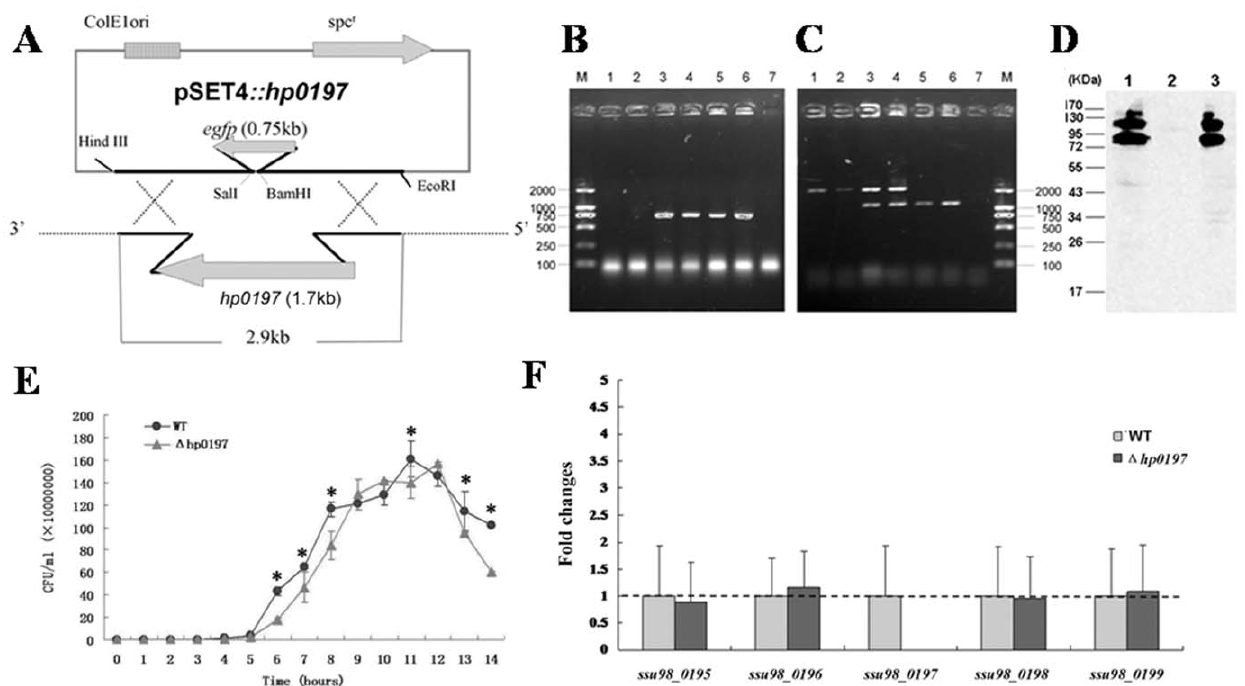
Figure 1. Construction and confirmation of D hp0197 and a complementary strain, c D hp0197 . ( A ) Construction strategy for D hp0197 , which was derived from the SS2 strain 05ZY. Approximately 600 bp of sequence flanking hp0197 was constructed into the temperature-sensitive S. suis - E. coli shuttle vector pSET4s, hp0197 was replaced with egfp . ( B ) The egfp gene could not be amplified from the WT strain (lane 1 and 2) but was amplified from the D hp0197 (lane 5 and 6) and c D hp0197 strains (lane 3 and 4). ( C ) A PCR targeted to the 176 bp and 252 bp from the upstream and downstream sequence of hp0197 sequence respectively with primer pairs of HP0197-P1/HP0197-P2 was performed to confirm the successful construction. And a 2.1-kb band could be amplified from DNA of the WT strain (lanes 1 and 2), and a 1.2-kb DNA fragment could be amplified from the D hp0197 mutant (lanes 5 and 6). Two bands were amplified from the c D hp0197 strain (lanes 3 and 4). Lane 7 in A and B were PCR negative controls. ( D ) HP0197 antibodies did not bind proteins extracted from the D hp0197 mutant strain (lane 2) but was able to bind proteins extracted from the WT strain (lane 1) and the c D hp0197 strain (lane 3) in the immunoblot assay. ( E ) The growth rates of S. suis strains in THB. ( F ) qRT-PCR amplification of hp0197 ( ssu98_0197 ) flanking genes ( ssu98_0195 to ssu98_0199 ) yielded identical results in WT and D hp0197 while hp0197 could only be amplified from WT.